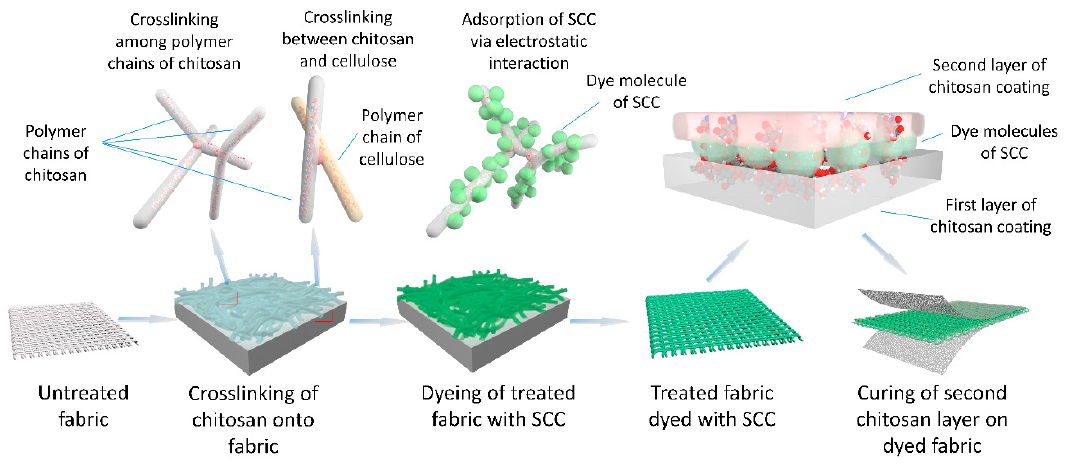
Figure 2. Schematic diagram of cross-linking of chitosan before and after dyeing.